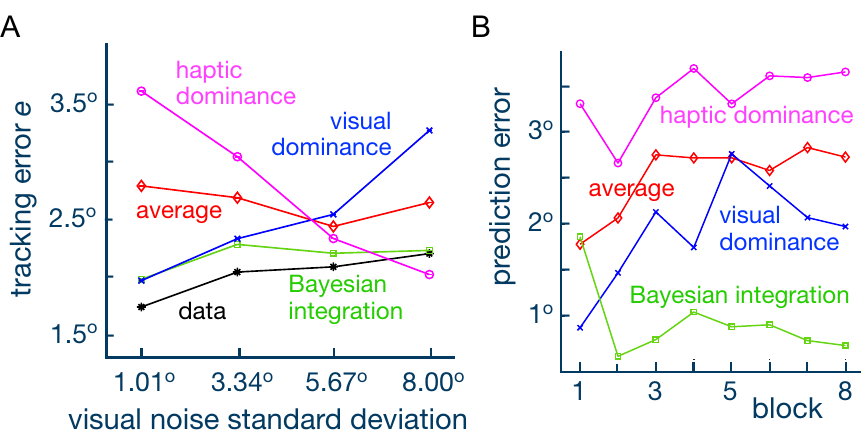
Figure 4. The best model that minimised the prediction error was the Bayesian integration of visual and haptic information. ( A ) The tracking performance predicted by each model is plotted as a function of the visual noise. With the increase of visual noise, the visual dominance model diverged from the experimental data. In contrast, the haptic dominance model predicted large error with low visual noise, which was different from the data. The error predicted by the Bayesian integration model was closest to the empirical data for all levels of visual noise. ( B ) The prediction error from each model is plotted as a function of the block number. In the first block, the visual dominance model yielded the lowest prediction error. From the second block onwards, the Bayesian integration model outperformed the others, with both the visual dominance and the averaging models’ predictions inflating with trials. The haptic dominance model yielded the worst